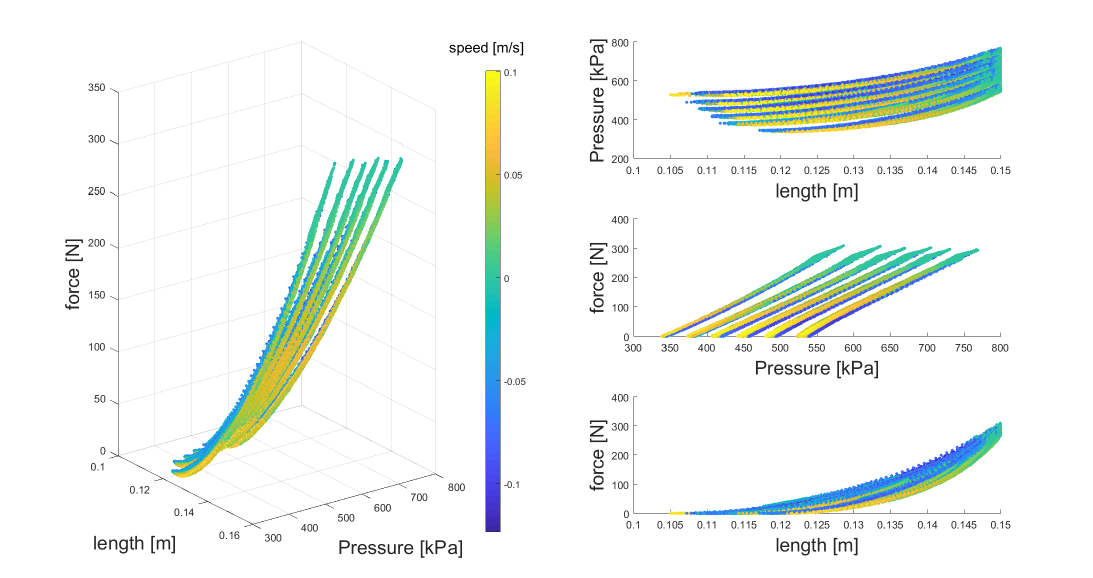
Figure 4. Identified model of PAM. ( left ) The muscle length, pressure and force are shown with the three axes. The color shows the muscle length contraction speed (negative). ( right ) The three subfigures show the relations in the 2D for illustrating relation between different muscle parameters which are not clear in 3D